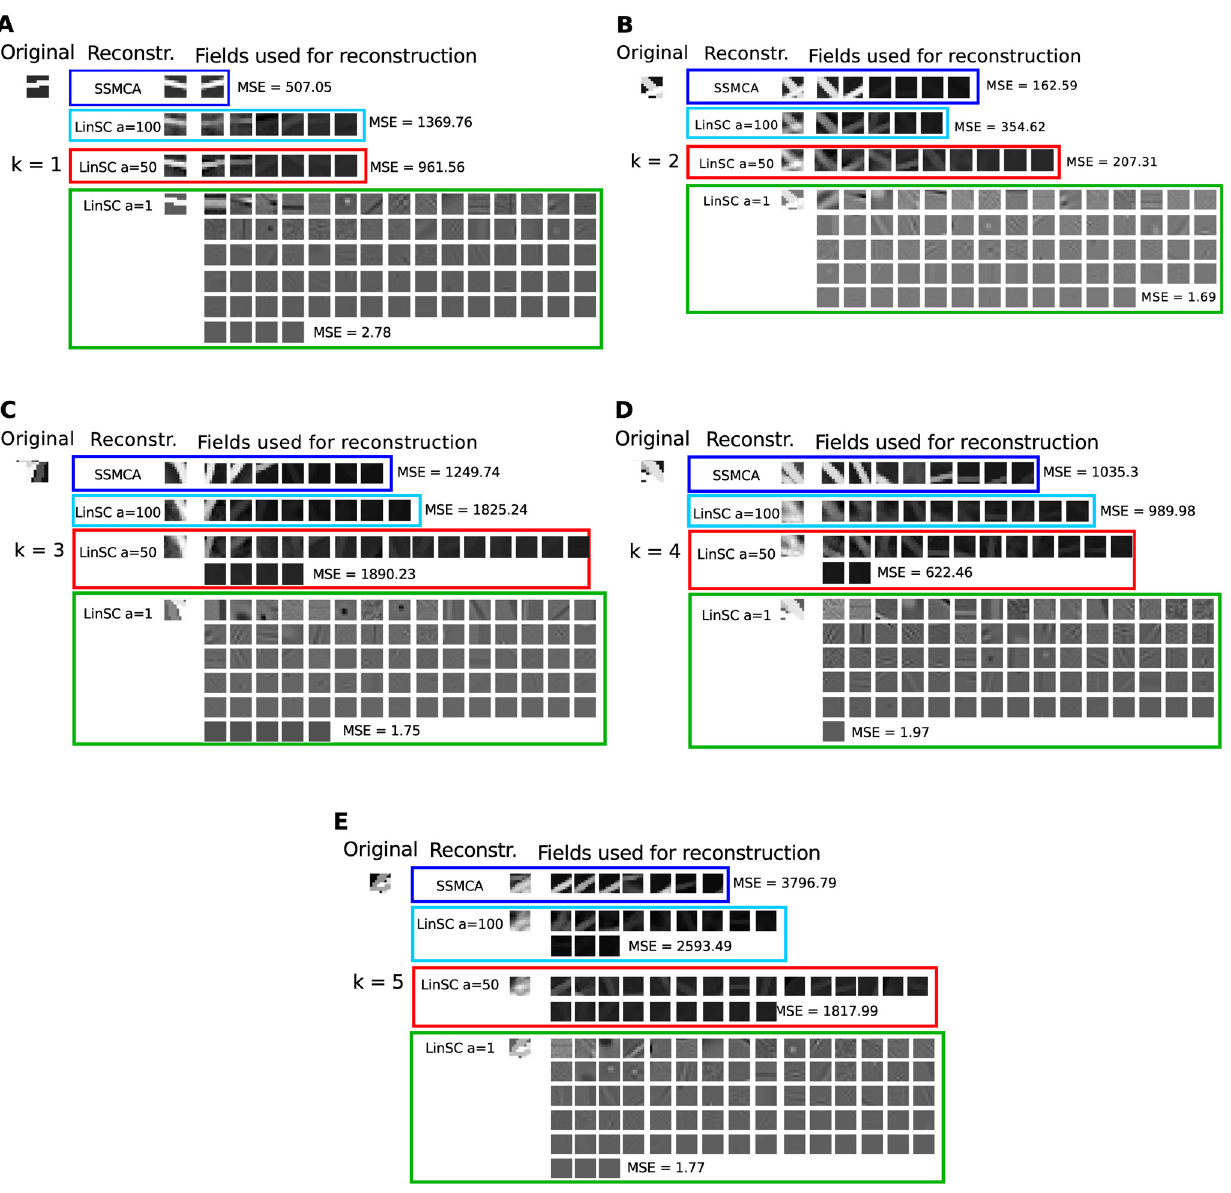
Fig 7. Comparison of linear and nonlinear sparse coding on image reconstruction. Shown are a handfull of real data points of varying complexity in terms of the number of strokes k in each image ( k 2 (1,5) strokes per image), the components/fields learned by the various algorithms, the corresponding reconstruction of the given data point, and the mean squared error (MSE) of each reconstruction. A image with k = 1 stroke, B k = 2 strokes, C k = 3 strokes, D k = 4 strokes, and E k = 5 strokes. Regardless of image complexity — how many causes/strokes are in an image — the components used by the nonlinear method (SSMCA) resemble the true causes of the image: each component contains a single, interpretable stroke. On the other hand, none of the a parameterizations of the linear method yield stroke-like components, even when the solution is regularized to be as sparse as SSMCA ( a = 100). Note: all images in the a = 1 case appear brighter than they actually are, due to visualization with a python toolbox, but are in reality of the identical brightness scale to the original data point (and all other shown cases), hence the reconstruction error (MSE) is very low.